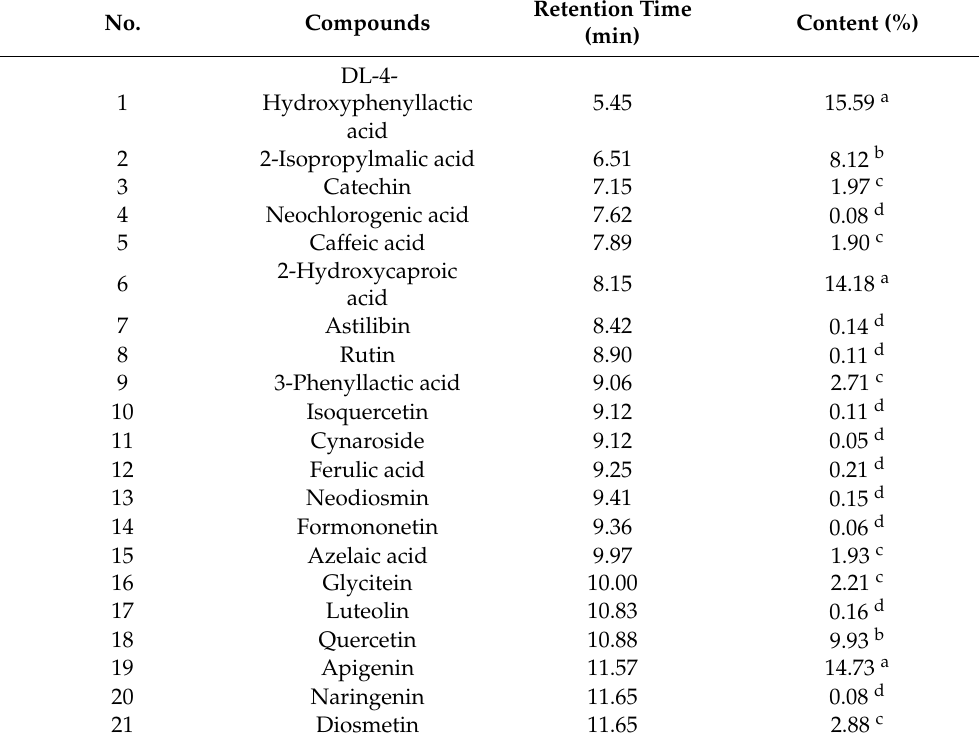
Table 2. Contents of functional compounds from HBVN were identified by UPLC–PAD–MS/MS.